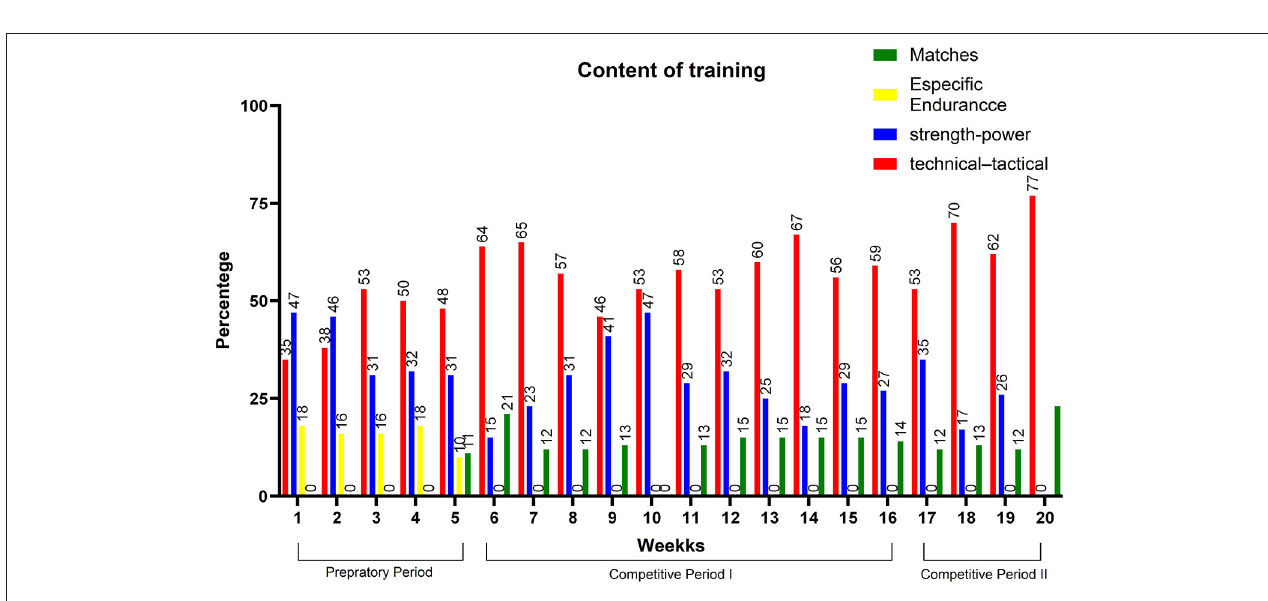
FIGURE 5 | Relative training